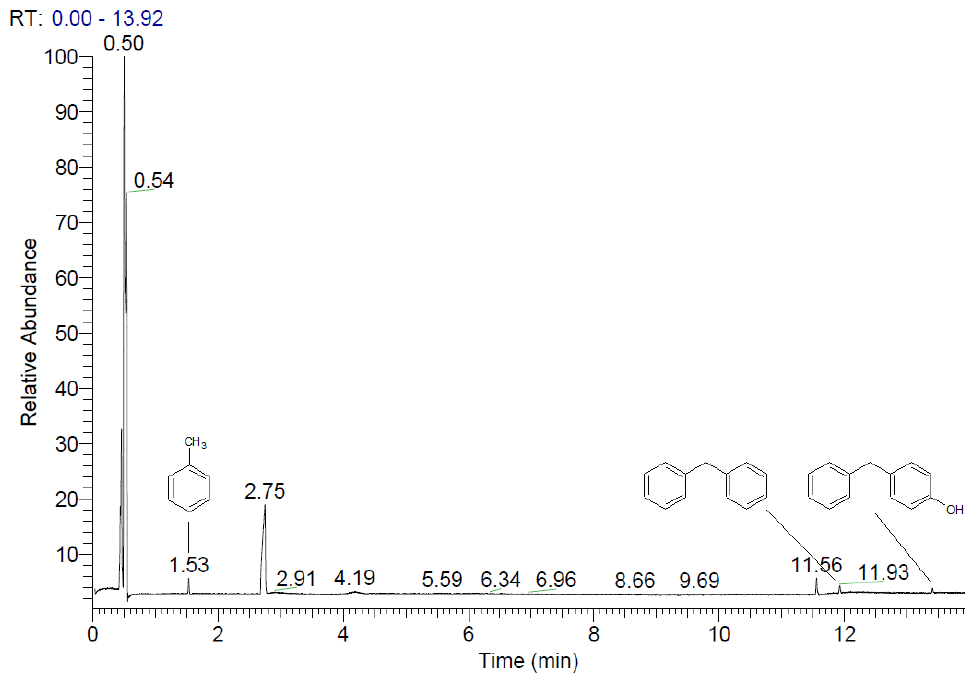
Figure 5. MS analysis of Ni/CaO ‐ Al 2 O 3 catalyst surface rinsed with acetone after the process. No toluene decomposition reaction products were present on the surface of NiO/(CaO ‐ Al 2 O 3 ) catalysts, and only a trace amount of C 7 H 8 (RT = 1.53 min) was adsorbed (Table 3). No nitrogen oxides in gas after reaction or nitrogen ‐ containing intermediate products such as nitrotoluene on catalysts’ surfaces were identified for all of the systems studied. Table 3. Compounds adsorbed on catalysts surface after the process [24].